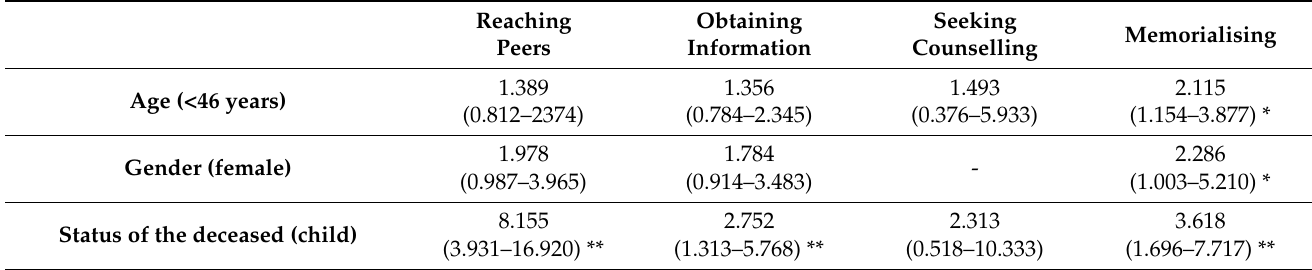
Table 4. Multivariate analysis of factors associated with the use of the